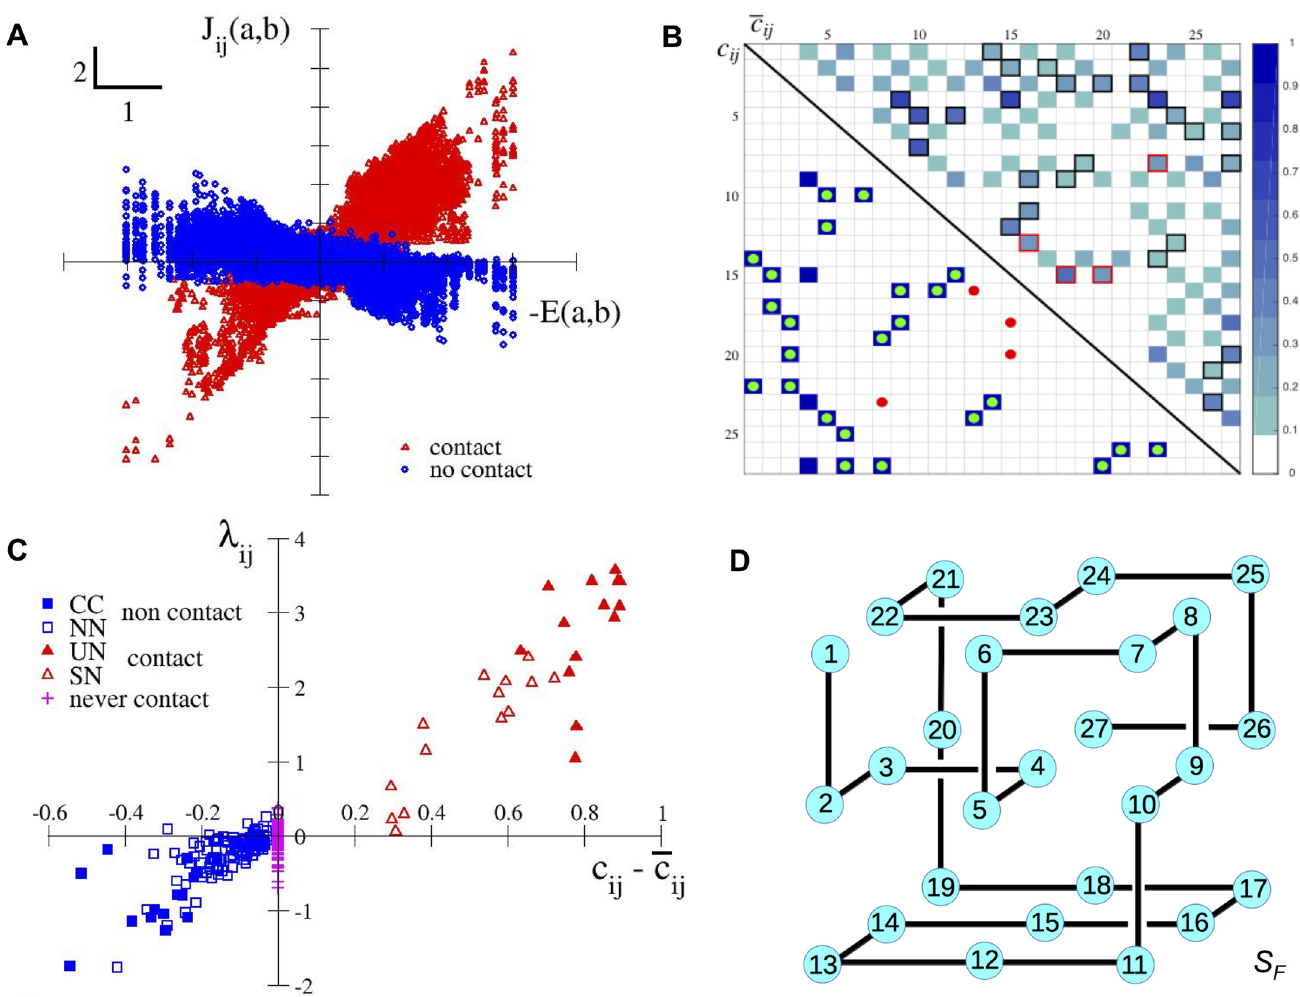
Fig 4. Inferred Potts couplings encode energetics and structural information about native and competitor folds, reflecting both positive and negative designs. A. Values of J ij ( a , b ) (inferred from a MSA of structure S B with the Potts-ACE method) vs. − E ( a , b ) across all pairs of sites i , j and of amino acids a , b (found at least once in the MSA on those sites). Couplings and MJ energy parameters are shown in the consensus gauge, in which the entries attached to the most probable amino acids in each site are fixed to zero. Red symbols correspond to pairs ( i , j ) in contact, while blue symbols correspond to no contact. B. Lower-triangle: contact map c ij of structure S B . Full blue squares correspond to pairs of sites i , j in contacts. Green and red dots show, respectively, true and false positives among the 28 largest scores F APC with the ACE method (Methods). Upper triangle: average contact map (cid:2) c , computed ij ij . over all competitor folds weighted with their Boltzmann weights (Methods). The four missed contacts (all touching the central site 4) correspond to large (cid:2) c ij (cid:3) c (cid:2) Red squares locate the four false positives. C. Pressure λ ij for each pair of sites ( i , j ), computed from Eq [2], vs. c for structure S B . The 195 pairs of sites ij ij which can never be in contact on any fold due to the lattice geometry are shown with magenta pluses. The 28 contacts on S B (red symbols) are partitioned into the Unique-Native (UN, 14 full triangles) and Shared-Native (SN, 14 empty triangles) classes, according to, respectively, their absence or presence in the closest competitor structure, S F (Fig 4D). The remaining 128 pairs of sites (blue symbols) are not in contact on S B , and are partitioned into the Closest- Competitor (CC, 14 full squares) and the Non-Native (NN, 114 empty squares) classes, according to, respectively, whether they are in contact or not in the closest competitor structure, S F . Similar results are found for S A , S C and S D , see Table 2 and Figs H, I, and J in S1 Text. As in Fig 4A, we use coupling and MJ entries expressed in the consensus gauge, since the consensus sequence corresponds, or is close to the best folding sequence, used as a reference sequence in our theoretical calculation of the pressure (S1 Text, Section III). Changing the gauge e.g. to the least-probable gauge affects the amplitudes of the pressures λ ij , but does not qualitatively alter the results. D . Structure S F , the closest competitor structure to S B . Note that the four missed contacts (among the top 28 F APC scores with the ACE method) are carried by the center of the cube (site i = 4 on S B and S F ), see fold S B in Fig 2A and its contact map in Fig 4B. Two of the four false positives are contacts on S F , and are thus in the CC